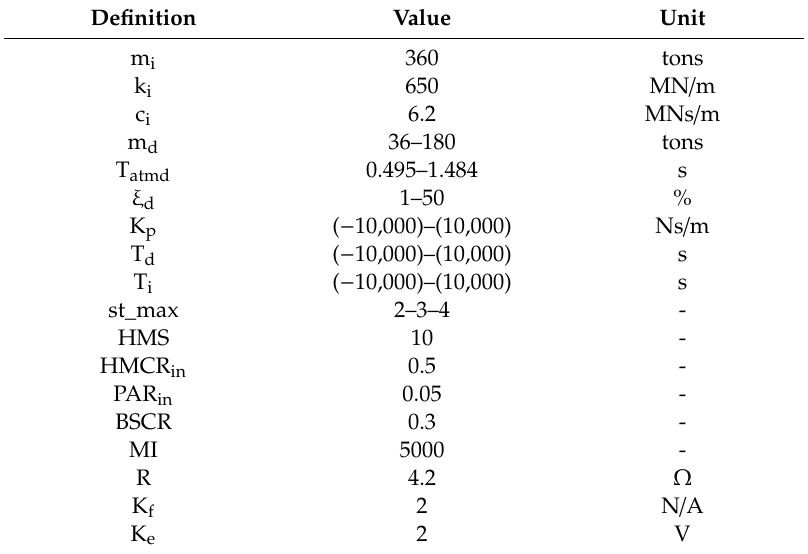
Table 1. The numerical data for structure case.